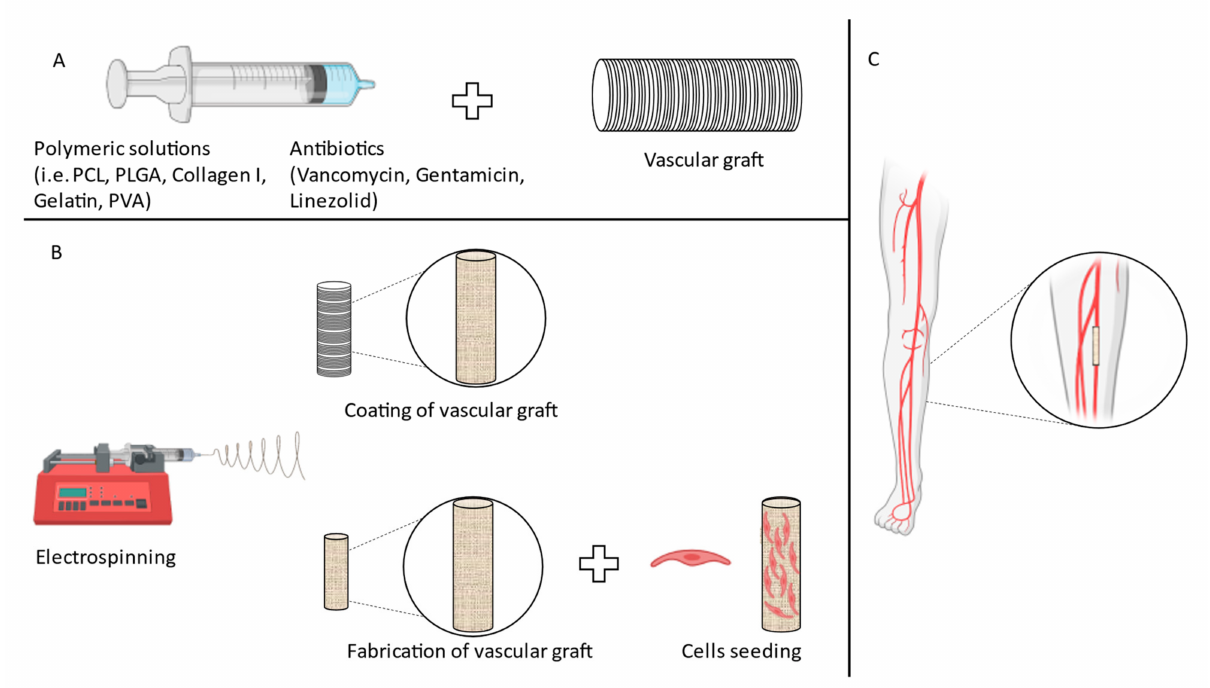
Figure 1. Different approaches to fabricate VG. ( A ) Schematic of the coating of VG. ( B ) Different approaches to obtain VG with antimicrobial properties. ( C ) Schematic of PAD surgical